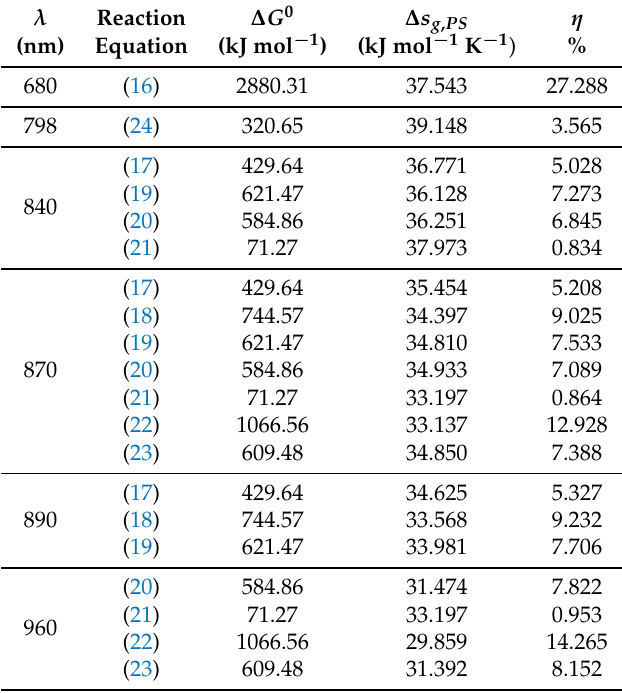
Table 1. Entropy generation and efficiency for photosynthesis in relation to 1 mol C (data summarized in